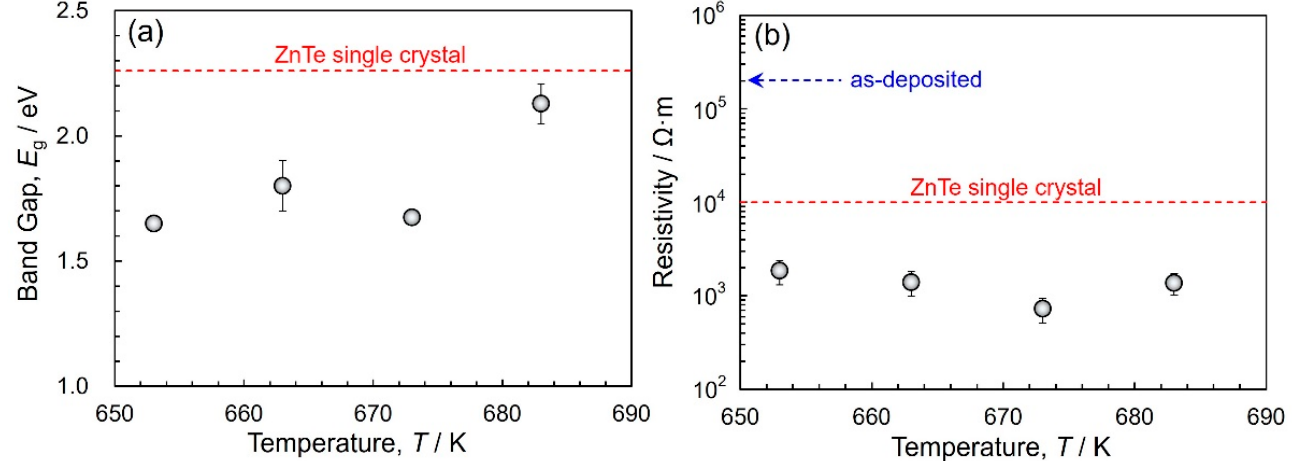
Figure 6. Effect of annealing temperature on the energy band gap ( a ) and resistivity ( b ) of electrodeposited ZnTe thin films onto ITO glass substrates.